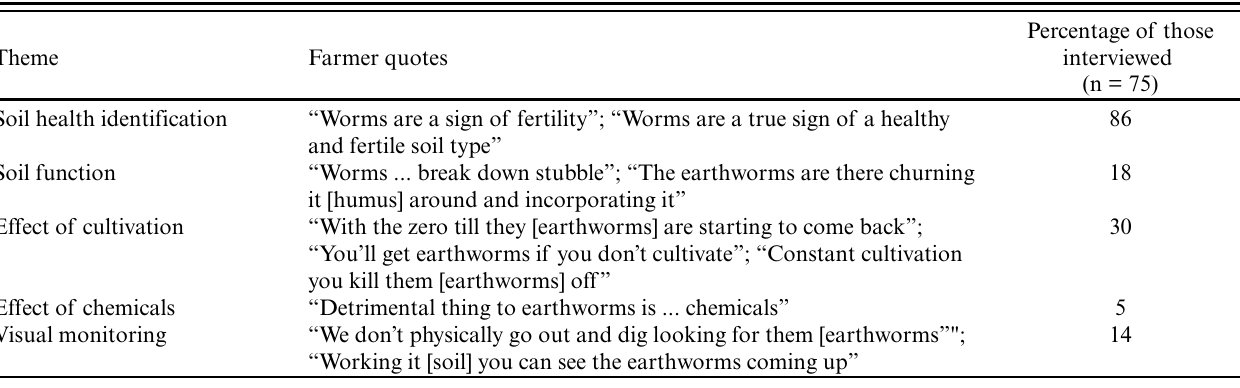
Table 1 . Farmers’ understanding of earthworms and their role in soil health identification and soil function